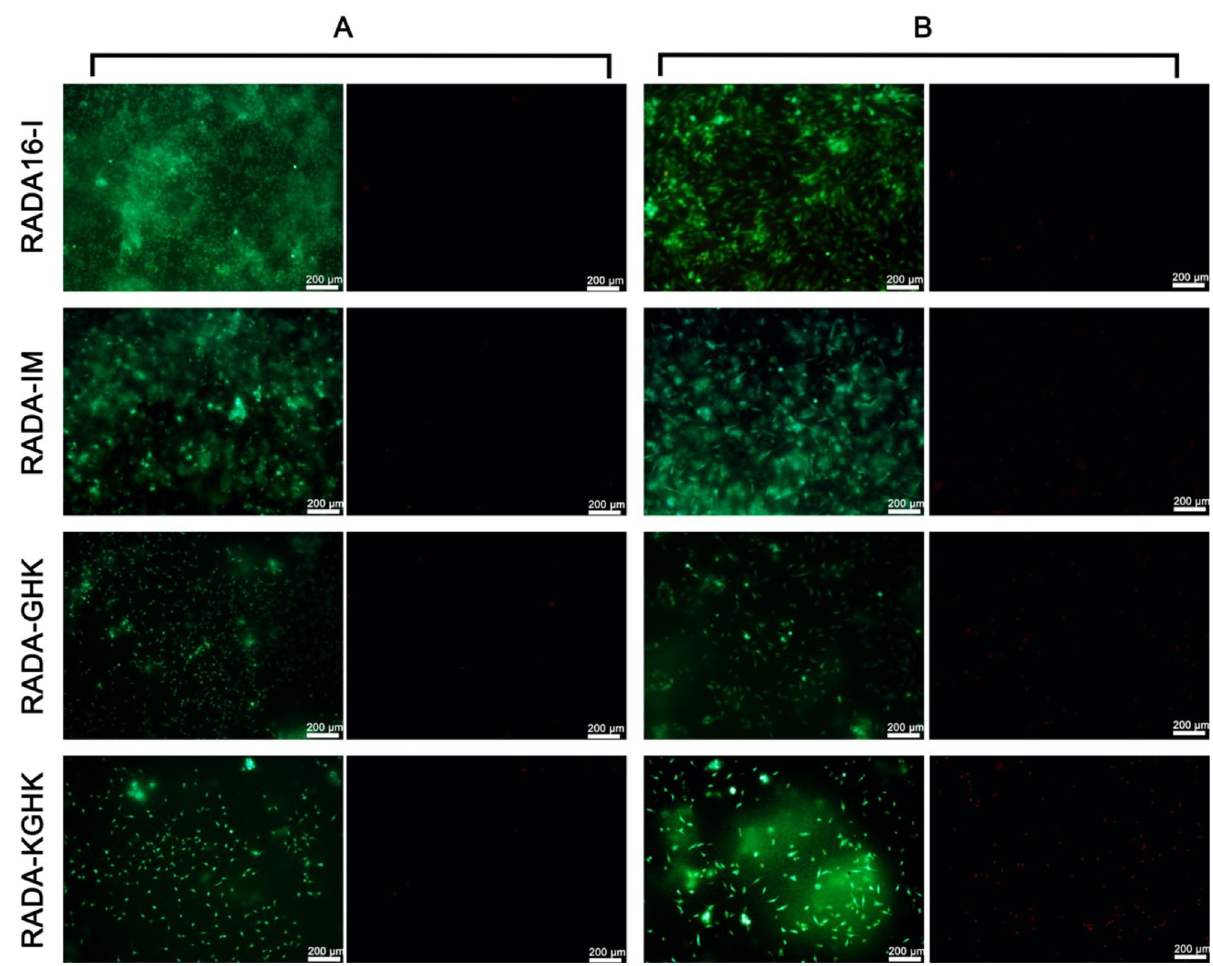
Figure 13. Microscope images of 46BR.1N fibroblasts ( A ) and primary fibroblasts ( B ) after seeding on RADA hybrids for 72